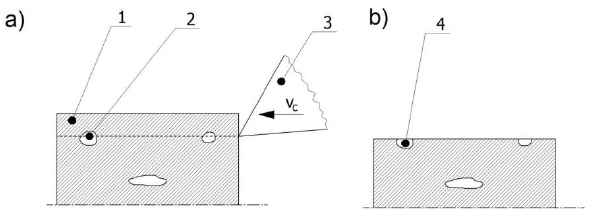
Figure 2. Formation of surface defects after machining a workpiece with internal defects ( a ) 1—machined layer, 2—internal defect, 3—tool, ( b ) 4—surface defect. Surface layer properties can be divided into two groups: stereometric and